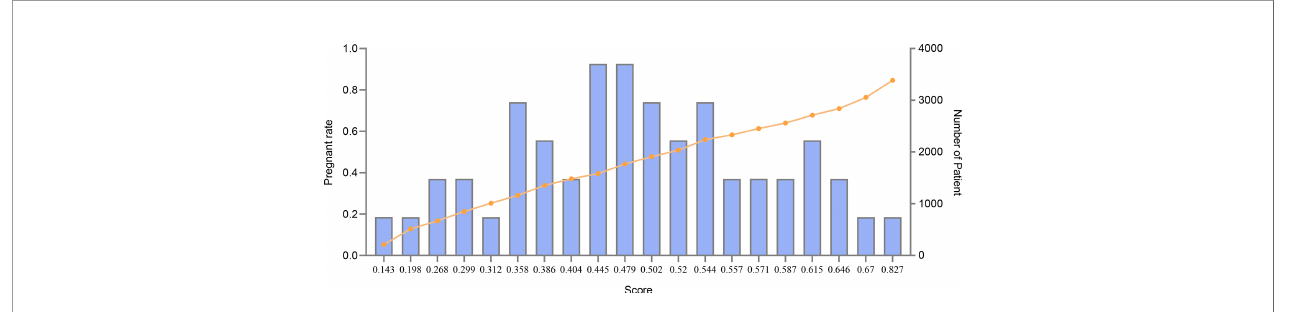
FIGURE 5 | Pregnancy rate and total scores of patients. This fi gure described the association between pregnancy rate and total scores of patients. The X-axis represented the score. The line represented pregnancy rate. The bar represented the number of